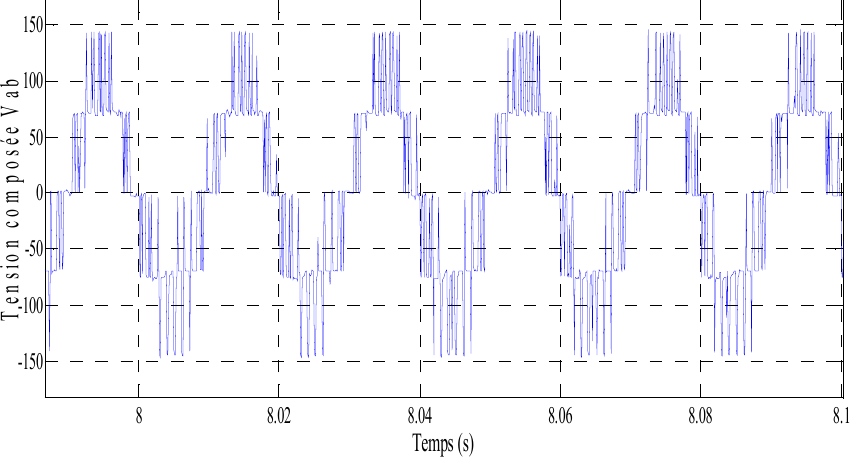
Figure 7. 3L_NPC inverter output voltages. 2.2.2. Amelioration of FOC Strategy Using 3L_NPC Inverter